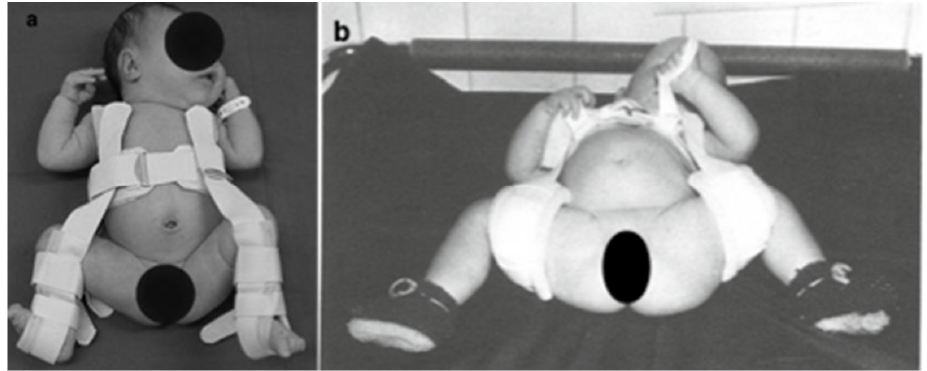
Figure 1. ( a ) is current from our setting. This is how the Pavlik harness is applied in human position. ( b ) Instead of the Pavlik harness, a Daimler bandage is used. The difference between the human position and the Lorenz position is clearly visible in the abduction up to more than 90° [12].